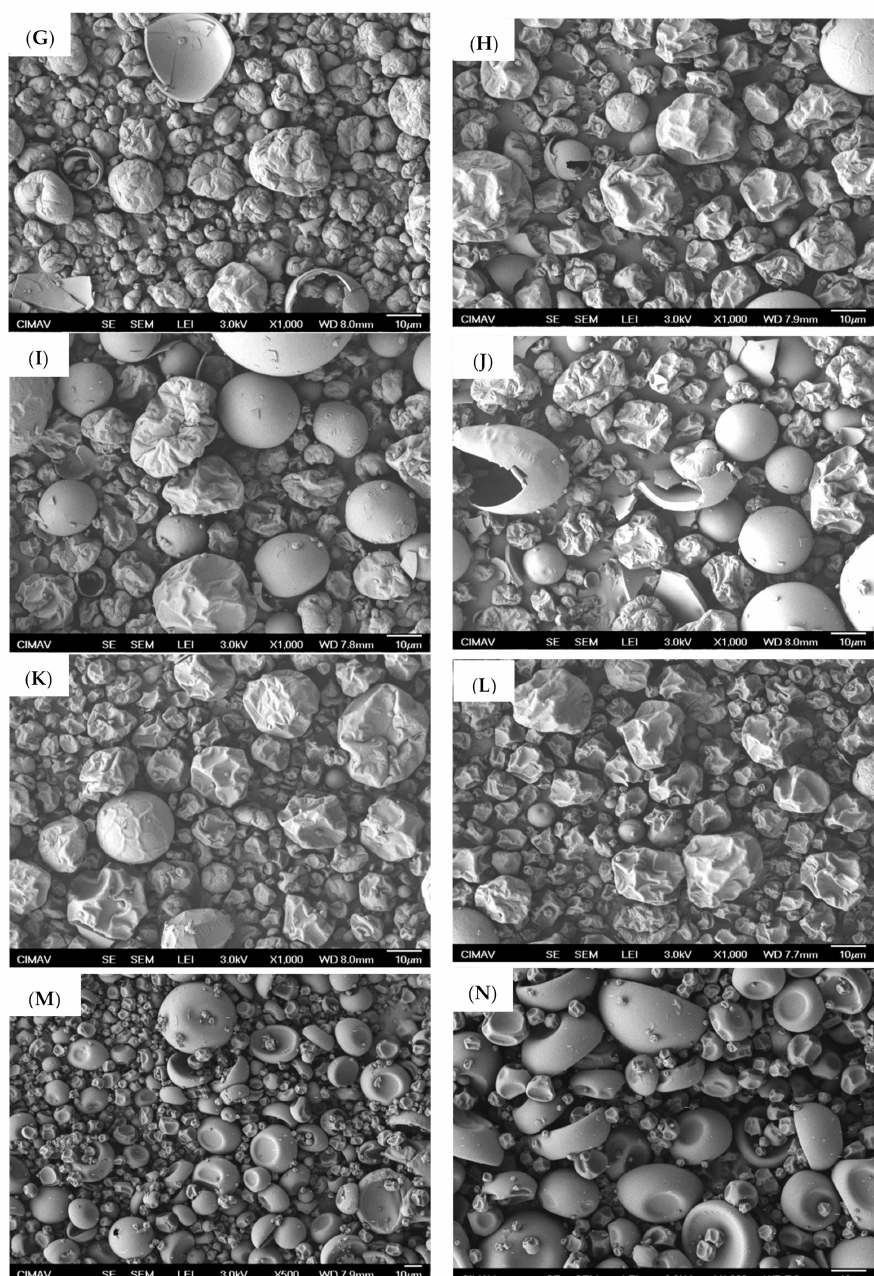
Figure 5. SEM micrographs of the particle morphology of the BJ-MX powders obtained under different drying conditions ( A – L ), and the MX employed as blank ( M , N ). Micrograph identification: ( A ) BS220[7.5], ( B ) BF220[7.5], ( C ) BS150[7.5], ( D